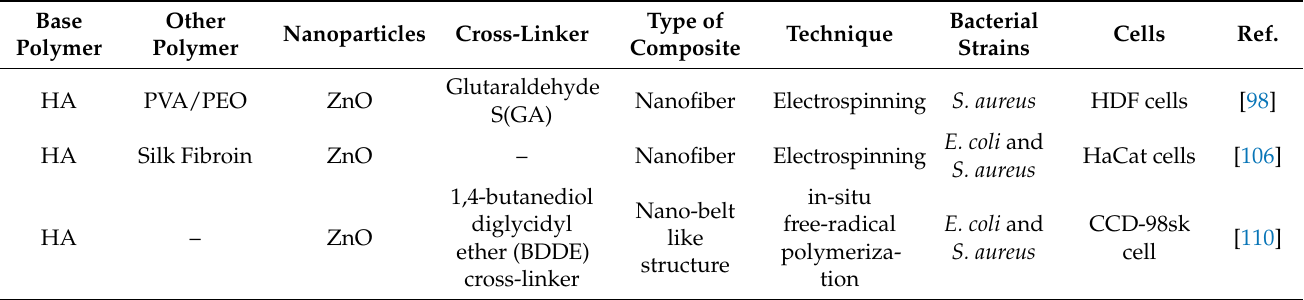
Table 3. HA-MO NPs for wound healing applications.